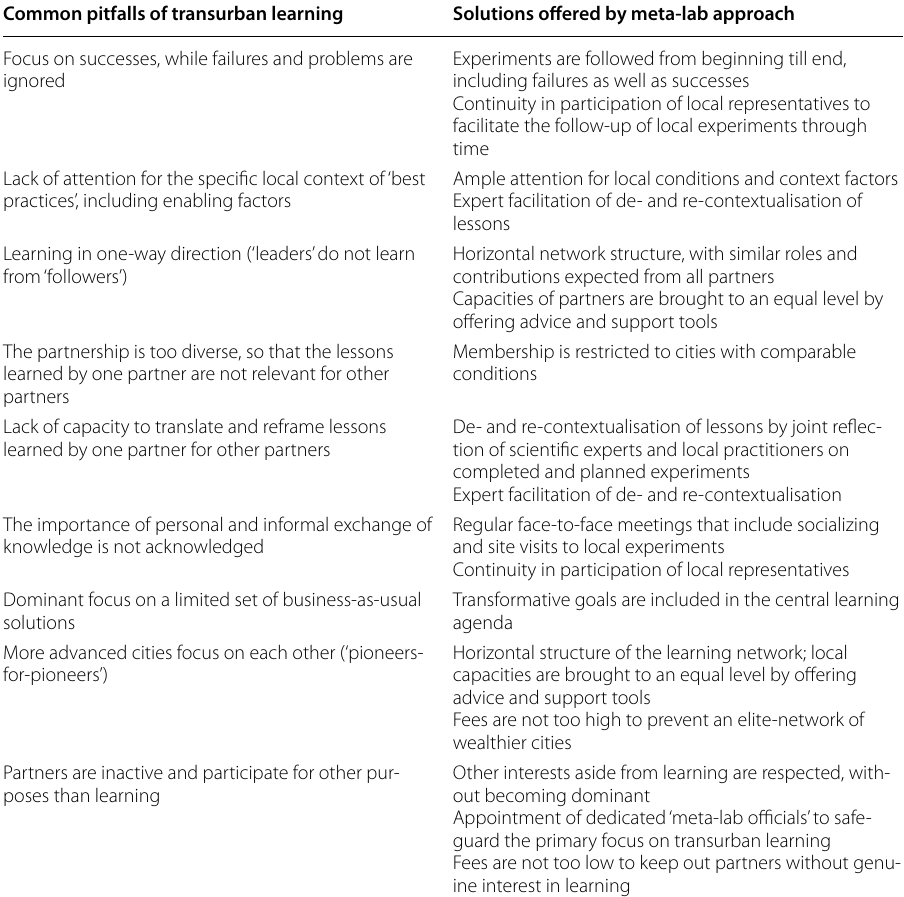
Table 2 Common pitfalls of transurban learning in city networks and how these are addressed by design elements and implementation conditions of the meta-lab approach Common pitfalls of transurban